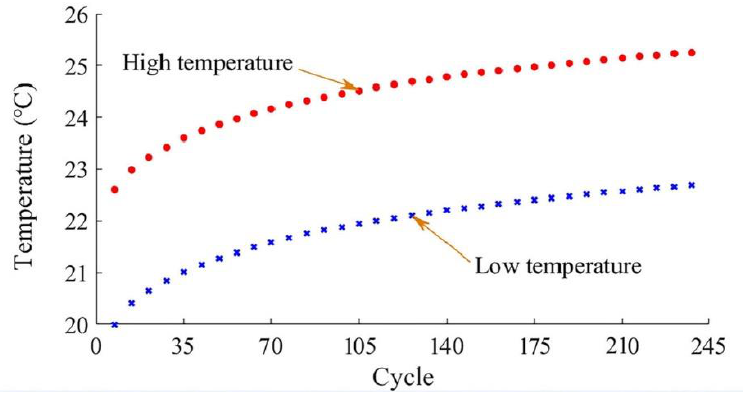
Figure 13. Temperature rise curve of the highest and lowest temperatures at the tip. Through a reasonable optimization of the mesh and boundary conditions, an isother- mal distribution for the cutter tooth was obtained via numerical simulation. The refinement of the mesh layer and step size depended on the importance of the position within the tooth. Figure 14 displays the temperature distribution of the front, back, and nose of the blade involved in milling. The temperature of the cutter tooth increased from 20 ◦ C to 25 ◦ C over 250 cycles.